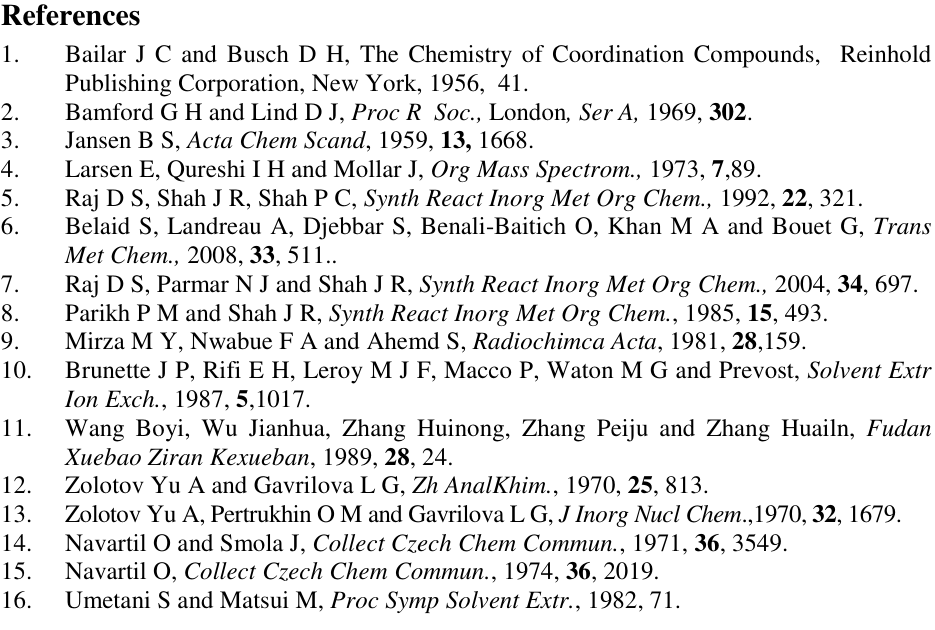
BT= Botrydeplaia thiobromine, N= Nigrospora Sp., RN= Rhisopus Nigricans, AN= Asperginus niger, AF= Aeprogines funigalus, AA= anida Albicans, AK= Andida krusegios candida